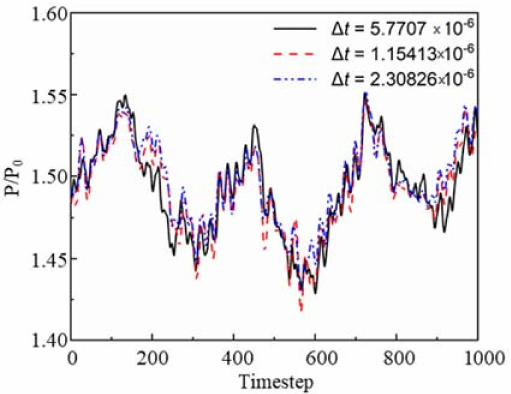
Figure 3. Time evolution of pressure coefficient with three different time steps for SVD